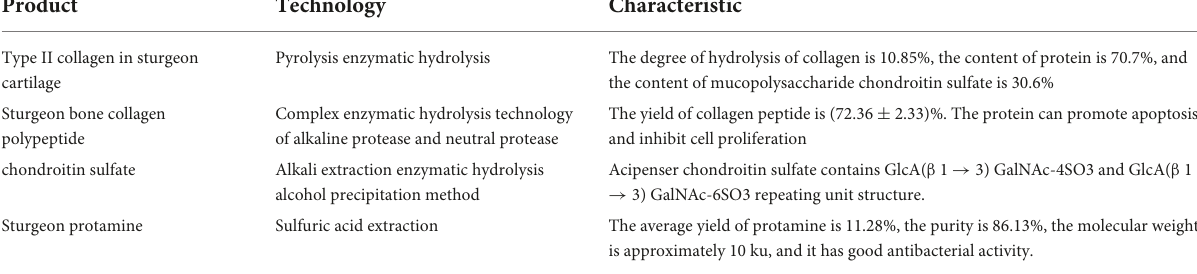
TABLE 4 Extraction methods and characteristics of byproducts from sturgeon bone